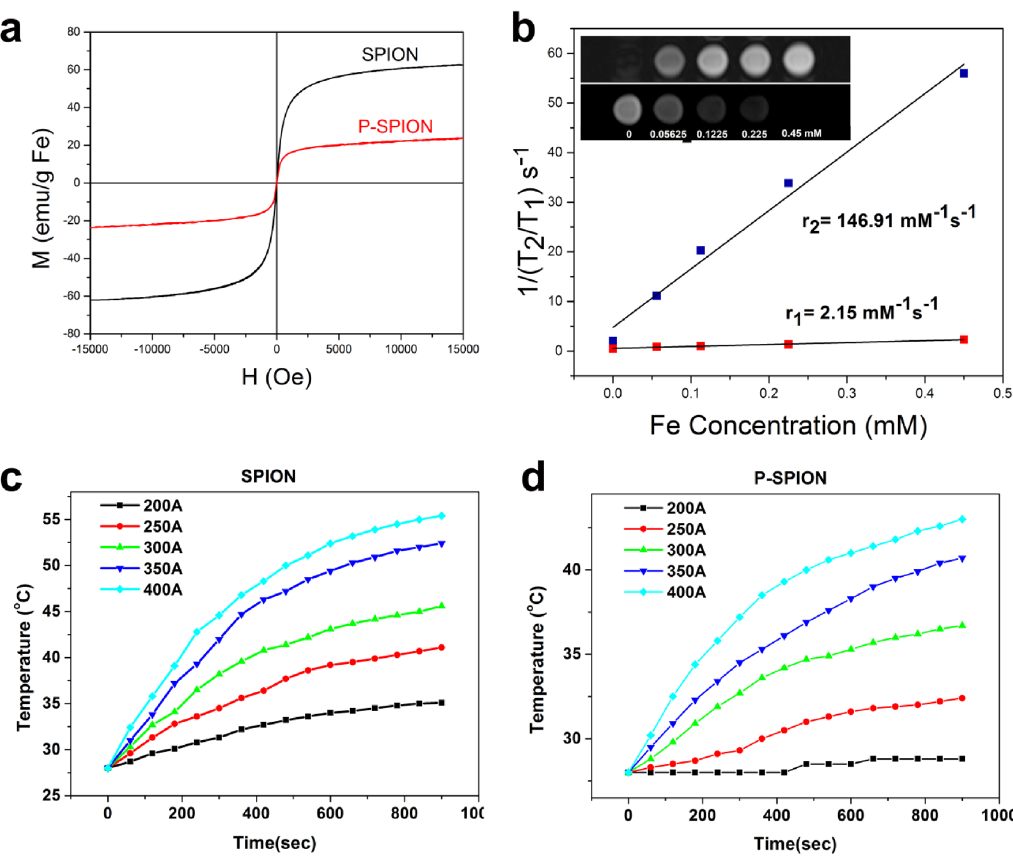
Figure 2. Magnetic and hyperthermic effects of P-SPIONs. ( a ) and ( b ) represents the super paramagnetic property and relaxivity effects of SPIONs and P-SPIONs respectively (inset represents the T 1 (Upper) and T 2 (lower) contrast MRI images of P-SPIONs). ( c ) and ( d ) represents the hyperthermia effects of SPIONs and P-SPIONs